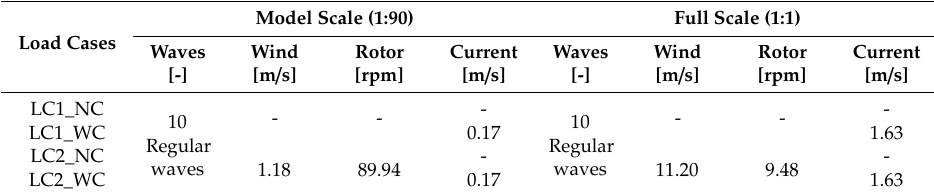
Table 6. Model test load cases.